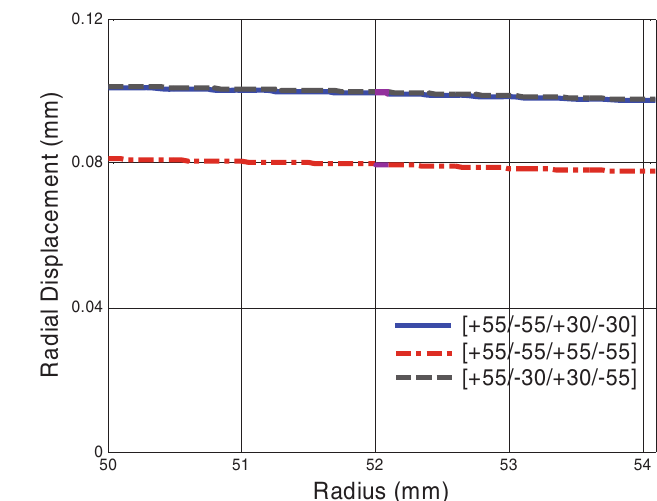
Fig. 6. The distribution of radial strain through the thickness.